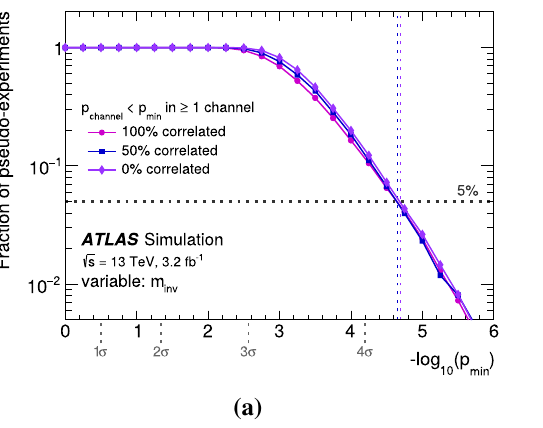
Fig. 5 A comparison of different correlation assumptions for scale variations: 100% correlated; 50% correlated and 50% uncorrelated; and 100% uncorrelated. The fractions of pseudo-experiments in the scan of the m inv distribution having at leastone p channel -value smallerthan p min